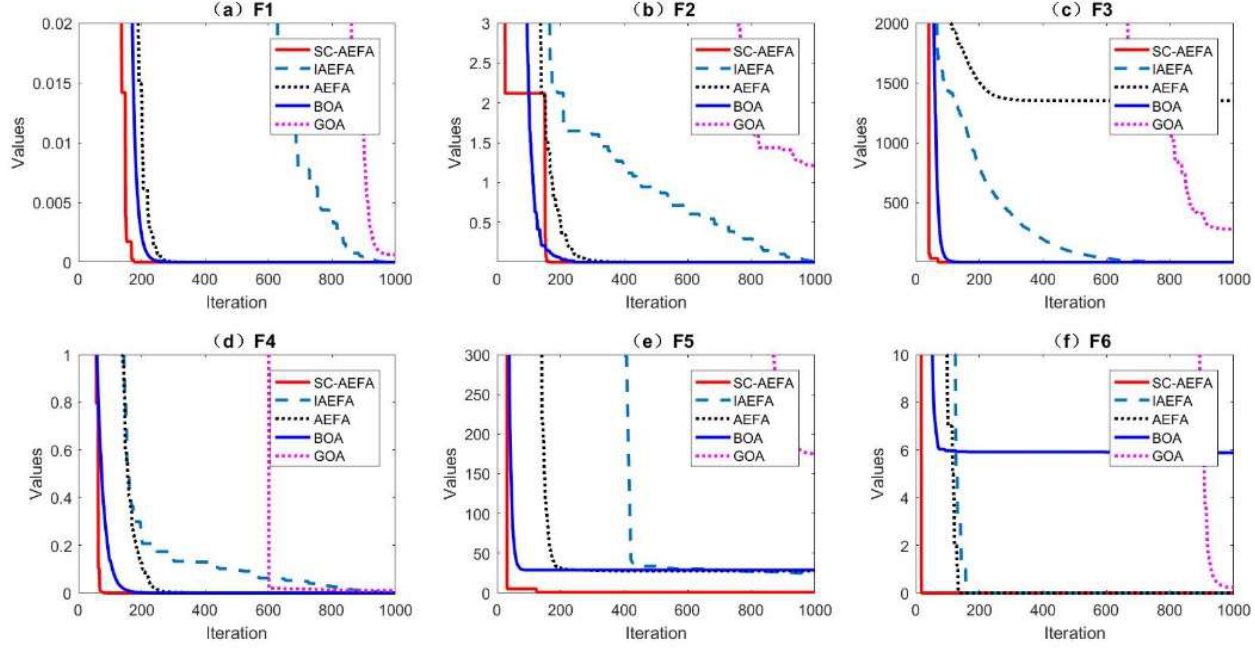
Figure 4. The comparison of the convergence results of different algorithms.